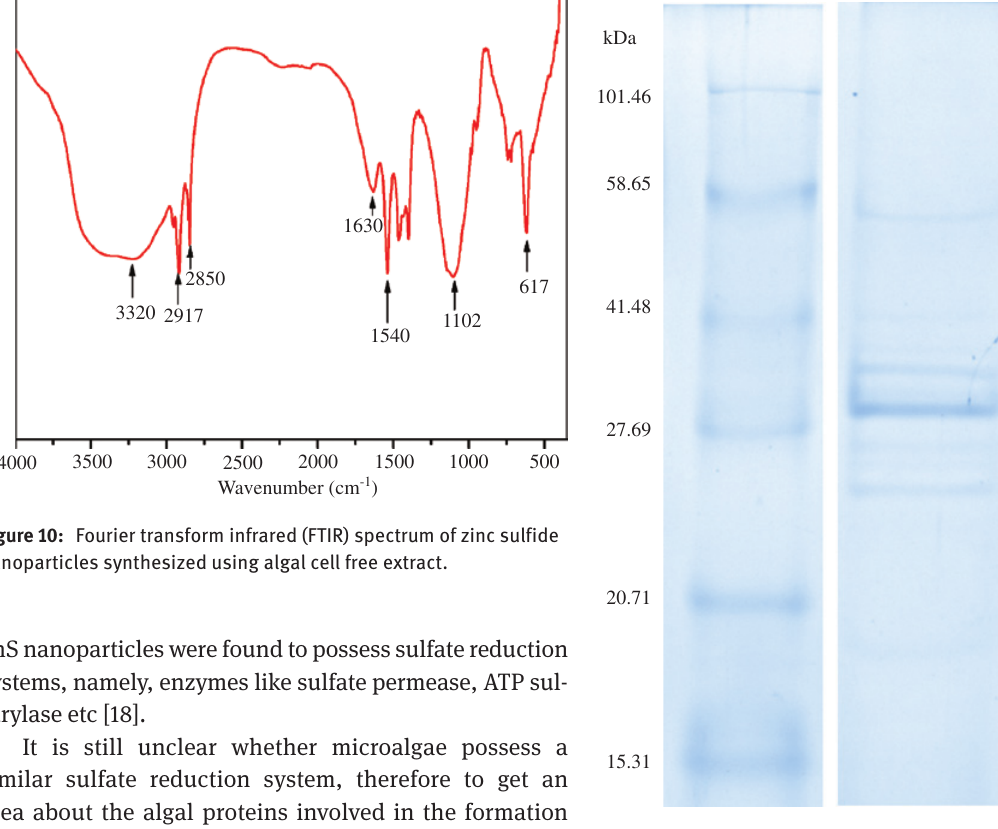
Figure 11: Sodium dodecyl sulfate polyacrylamide gel electropho- resis (SDS PAGE) analysis of proteins bound to ZnS nanoparticles using 1% SDS solution. Lane 1 corresponds to the molecular weight markers. Lane 2 represents the protein profile of proteins that were bound to zinc sulfide nanoparticles after boiling with 1% SDS